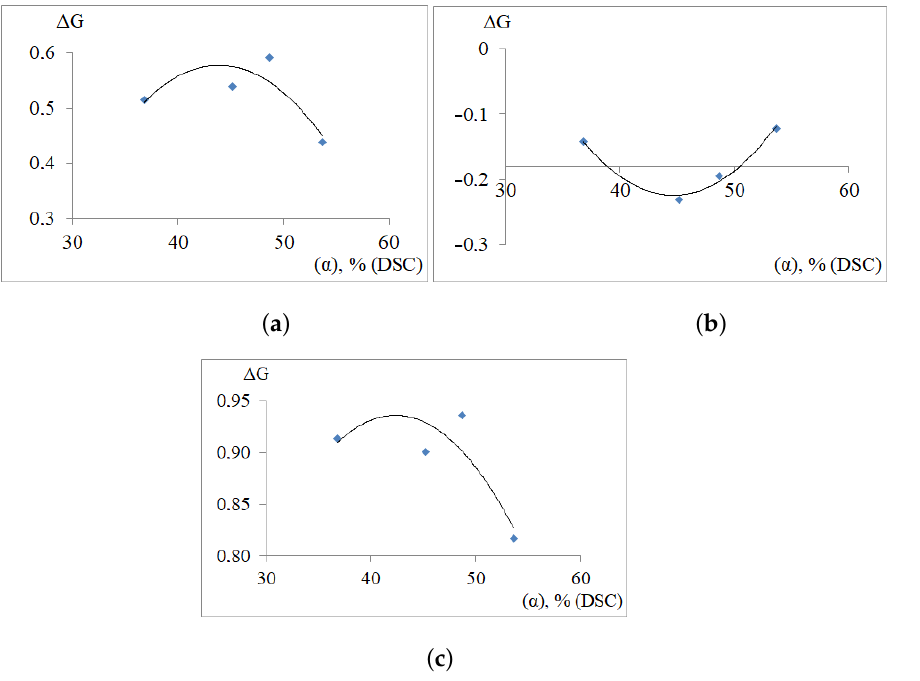
Figure 9. Dependence of the modulus defect on the degree of crystallinity ∆ G = f ( α ,% ) for β ( a ); µ ( b ); β k ( c ) dissipative processes in